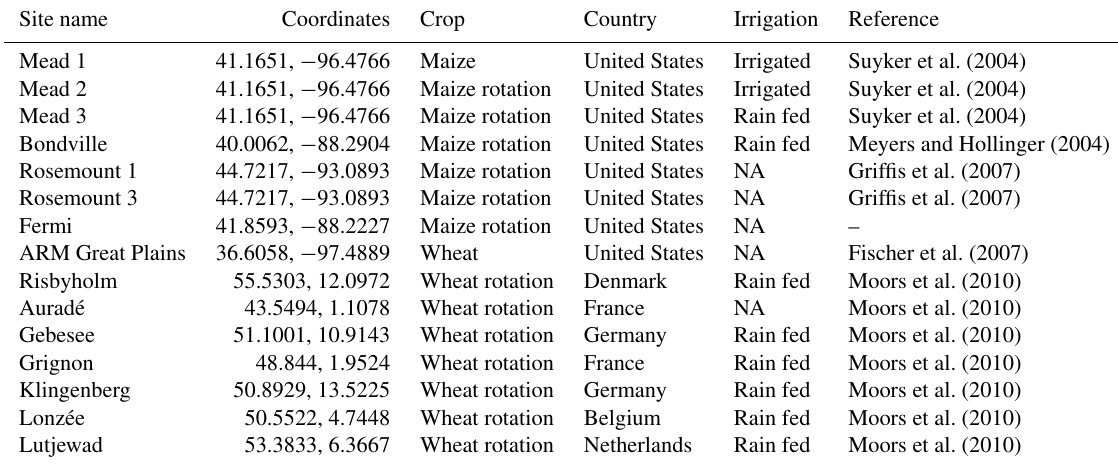
Table 1. Study sites are listed; all sites correspond to eddy covariance measurement sites.